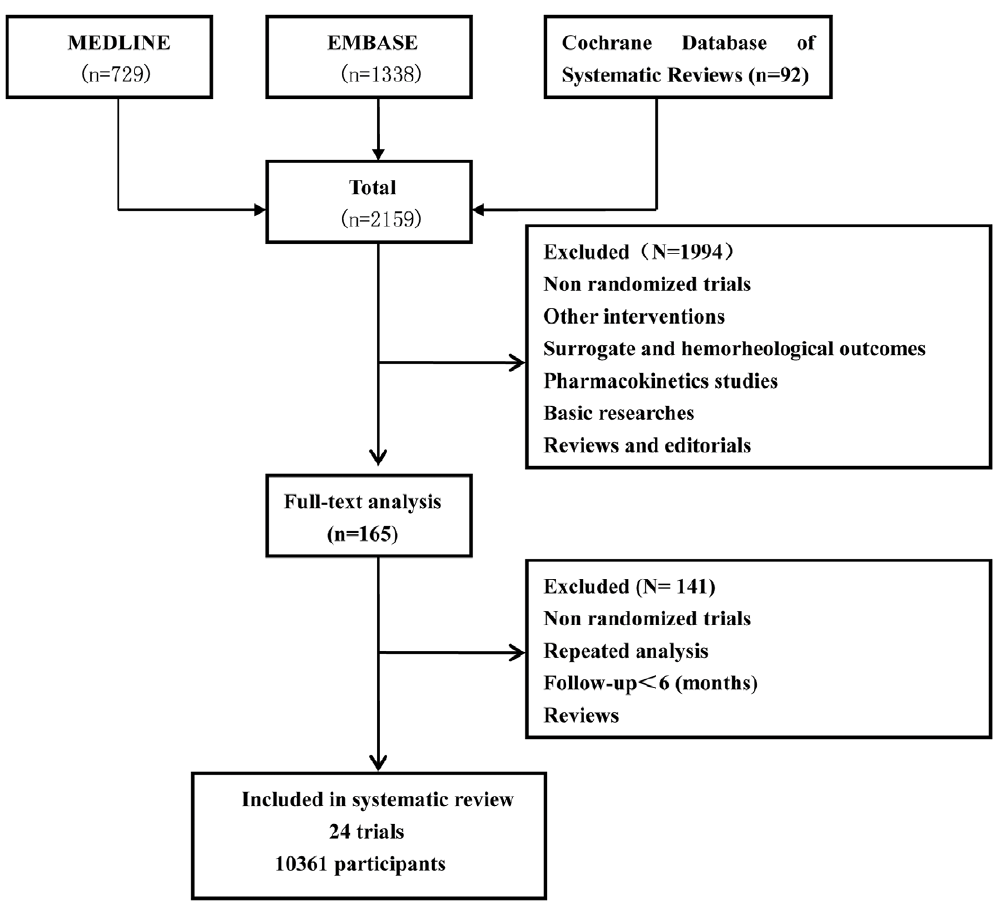
Figure 1. Flowchart demonstrating the literature screening process and reasons for exclusion are explained.